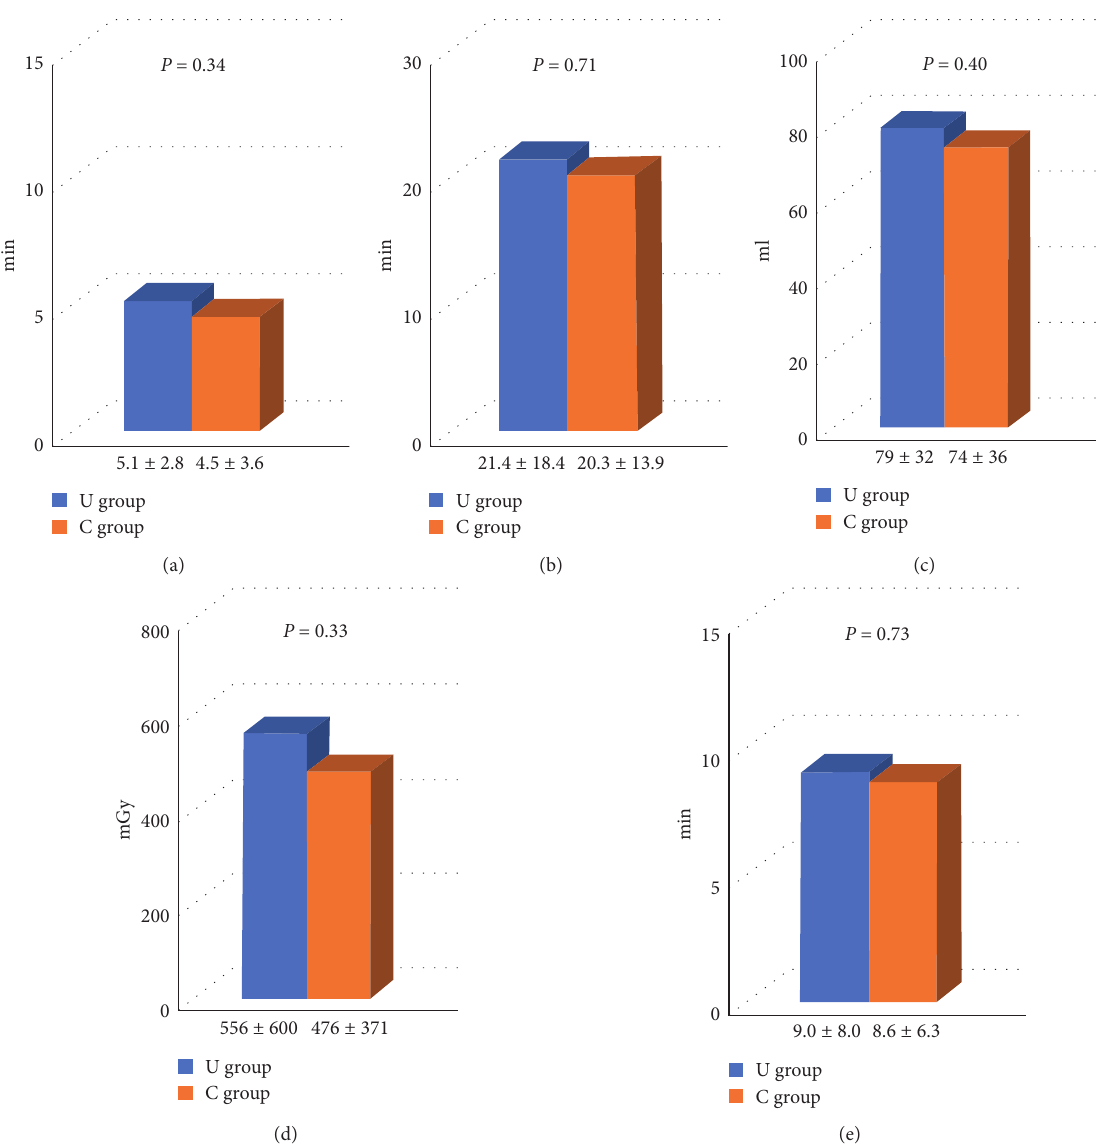
Figure 4: Procedural outcomes. (a) Puncture time. (b) Procedural time. (c) Contrast volume. (d) Radiation dose. (e) Radiation